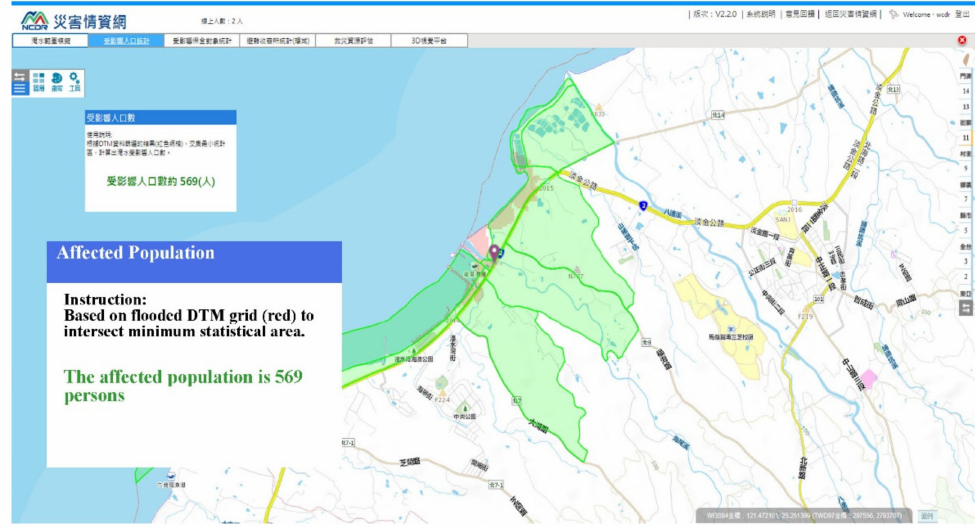
Figure 13. The flood-affected population of Sanzhi District.